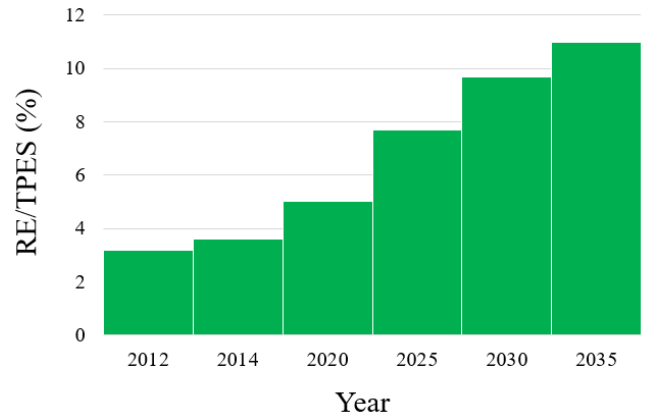
Figure 2. Supply targets for new and renewable energy technologies according to RPS [20,21].